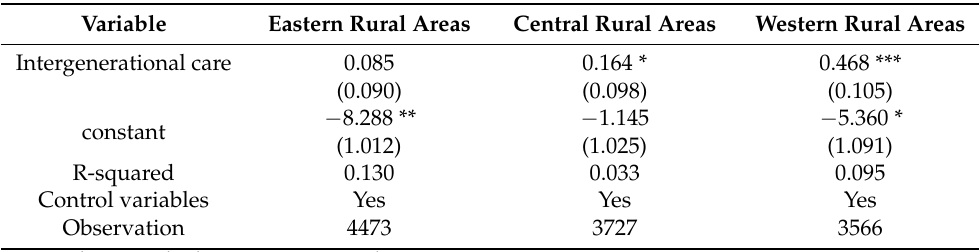
Table 4. The impact of intergenerational care on food diversity by regional heterogeneity indicators among three Chinese areas (eastern, central, and western) estimated result.